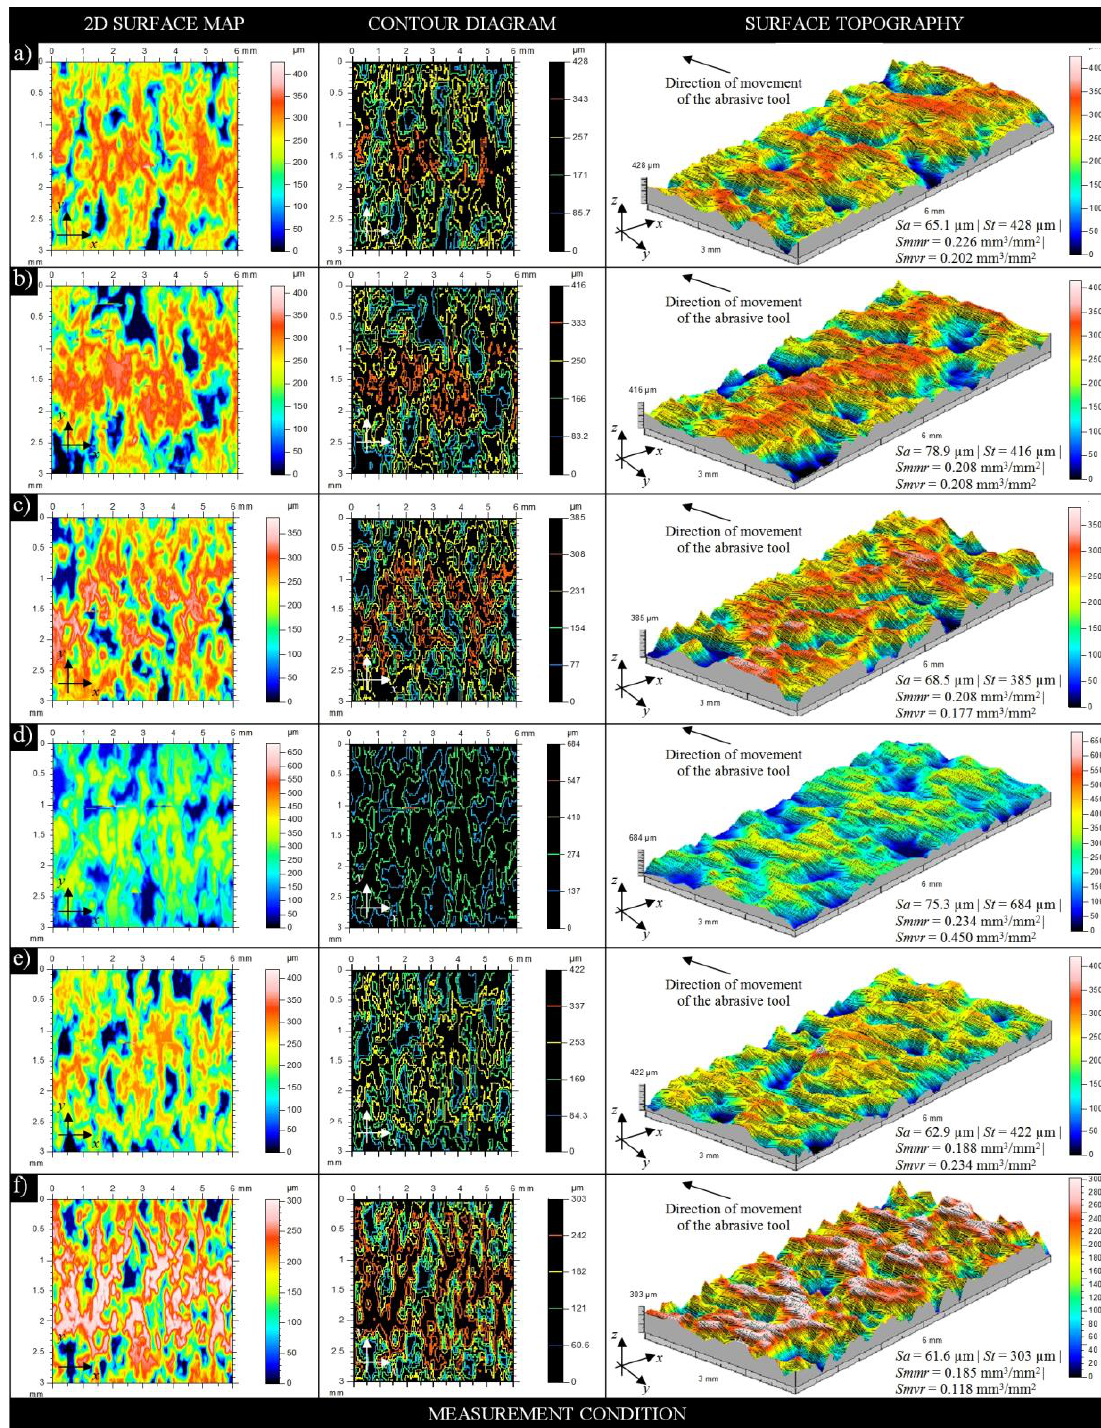
Figure 4. Collection of selected results obtained for the GWAS 1-35×10×10-9A5X60L10VE01PI-50 carried out using the stylus profilometer Hommelwerke Hommel-Tester T8000 for MoS 2 -treated samples—( a ) 1M20, ( b ) 1M30, and ( c ) 1M40, as well as MoS 2 -treated samples after the internal cylindrical grinding of INCONEL ® alloy 718—( d ) 2M20, ( e ) 2M30, and ( f ) 2M40.